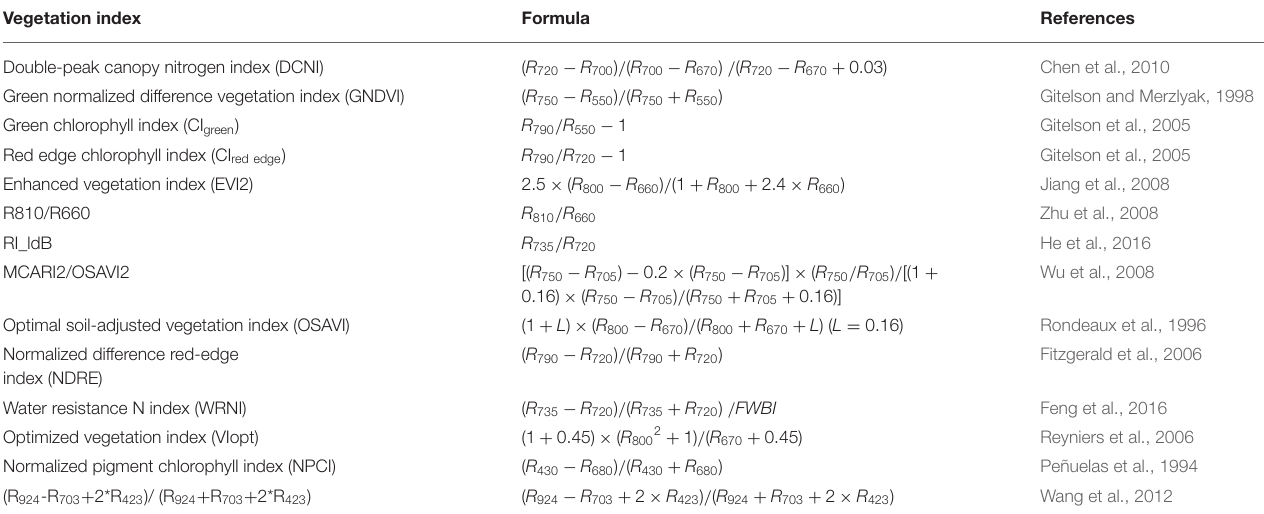
TABLE 2 | Classical vegetation indices used in this study. Vegetation index